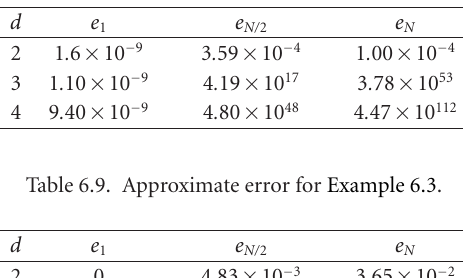
Table 6.8. Approximate error for Example 6.2.